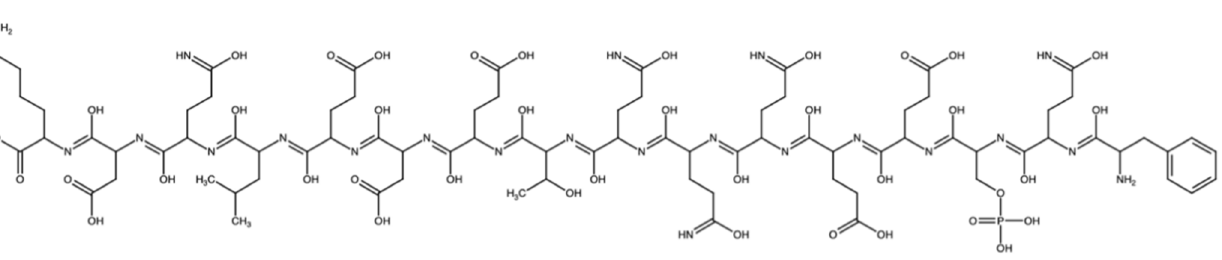
Figure 1. The chemical structure of casein.